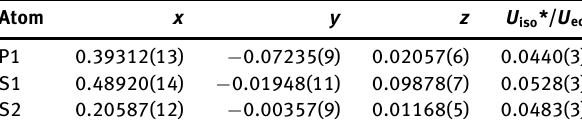
Table 2: Fractional atomic coordinates and isotropic or equivalent isotropic displacement parameters (Å 2